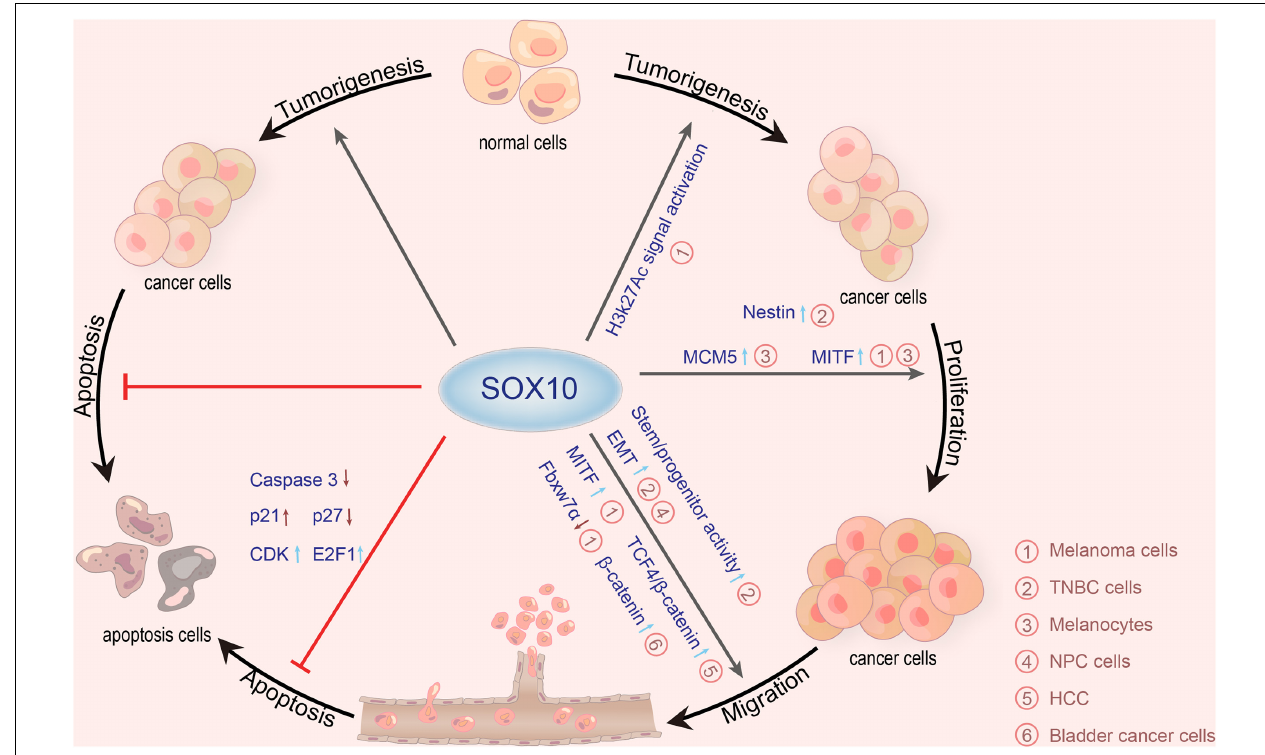
FIGURE 2 | Roles of SOX10 in various cancers. SOX10 exerts carcinogenetic actions via promoting tumorigenesis, proliferation, migration, and anti-apoptosis mechanisms. SOX10 plays tumorigenic roles in melanoma cells by stimulating H3K27Ac signaling. SOX10 also enhances the expression of nestin by directly combining with the promoter of nestin and upregulates the cancer stem cell characteristics of TNBC cells. In melanocytes, the deletion of SOX10 inhibits the expression of MCM5 to inhibit cell proliferation. Besides, numerous studies have demonstrated that SOX10 can directly activate MITF transcription to make melanocyte proliferation and melanoma migration, thereby promoting the development of melanoma. SOX10 knockout also inhibits the migration of TNBC cells and NPC cells by stimulating the EMT process. SOX10 increases the activity of stem/progenitor cells in TNBC cells by inducing nestin expression. Moreover, SOX10 promotes the combination of TCF4 and β -catenin to form a stable SOX10/TCF4/ β -catenin complex, promoting the proliferation of HCC. SOX10 also can promote the migration of melanoma cells mediated by Fbxw7 α . SOX10 knockdown in bladder cancer cells can inhibit migration and invasion of bladder cancer by upregulating the expression of β -catenin. SOX10 can inhibit the apoptosis of melanoma cells by reducing the expression of caspase-3 and p27 but elevates p21, CDK, and E2F1 (SOX10, sex-determining region Y-related high mobility group box 10; MITF, microphthalmia-associated transcription factor; MCM5, minichromosome maintenance protein 5; Fbxw7 α , F-box and beta-transducin repeat domain-containing 7 α ; CDK, cyclin-dependent kinases; E2F1, E2F transcription factor 1; EMT, epithelial-mesenchymal transition; HCC, hepatocellular carcinoma; TCF4, transcription factor 4; TNBC, triple-negative breast cancer; NPC, nasopharyngeal